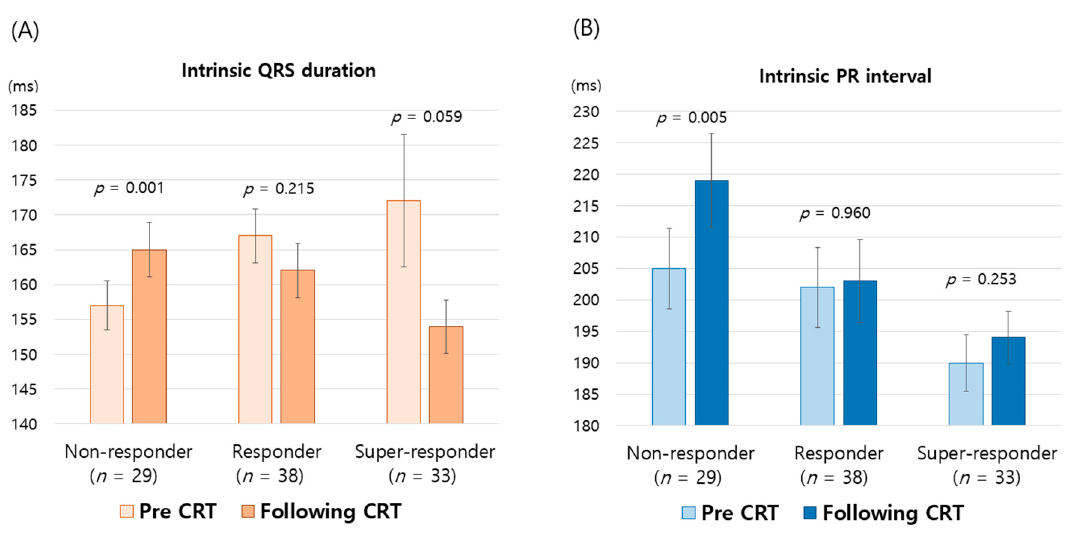
Figure 2. Changes in the native QRS duration ( A ) and PR interval ( B ) according to the degree of cardiac resynchronization therapy (CRT) response.